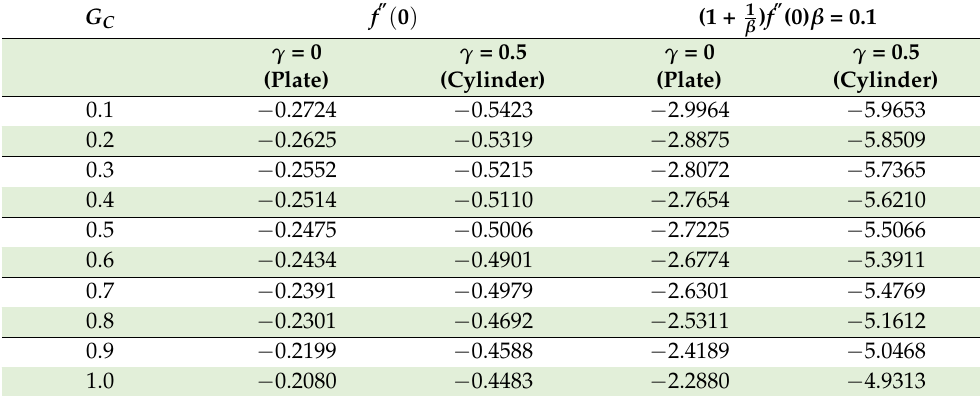
Table 3. Impact of G C parameter on skin friction coefficient.